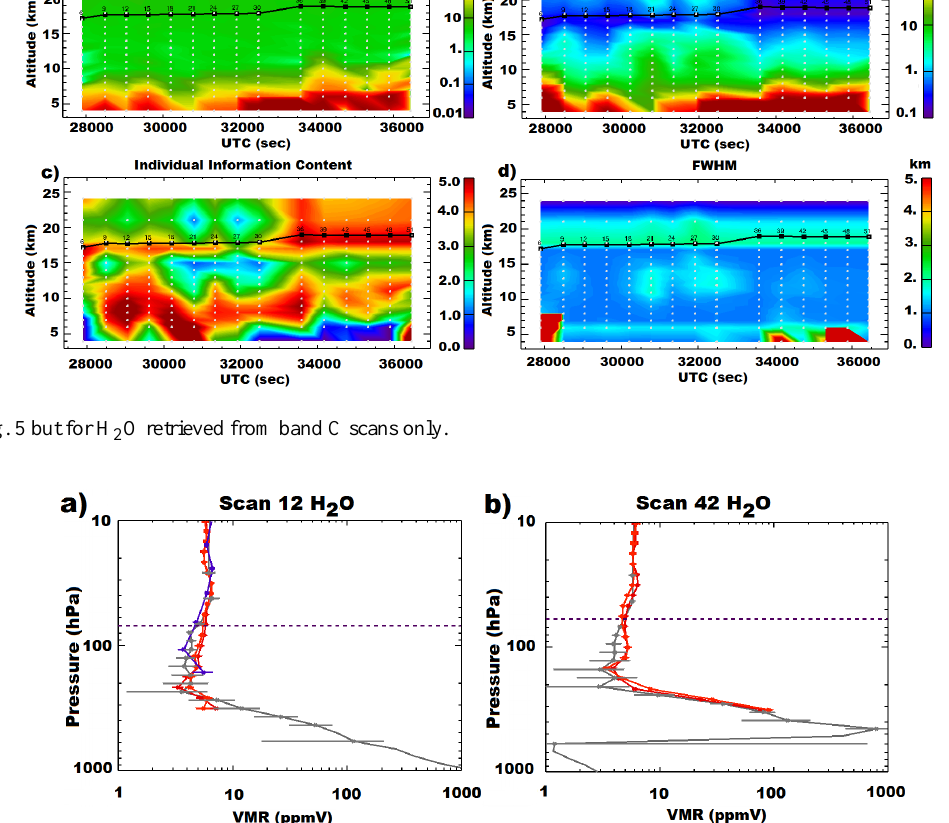
Fig. 7. Comparison of H 2 O profiles retrieved from MARSCHALS scans 12 and 42 (grey) with MIPAS/ENVISAT (blue) and MLS/Aura (red) H 2 O profiles. The horizontal dashed line represents the flight altitude level.